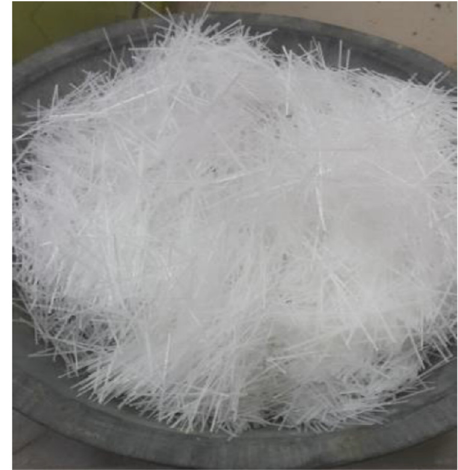
Figure 1: Polyole fi n Fiber – SikaFiber ® Force - 60.